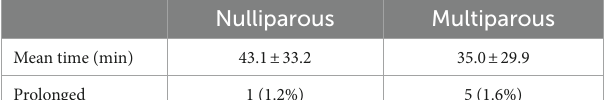
TABLE 7 Second stage of labor. Nulliparous